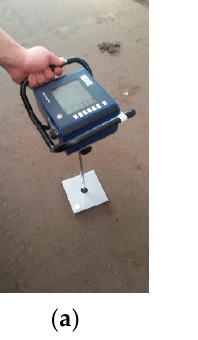
Figure 6. ( a ) Measurement of soil compaction by the electronic penetrometer Penetrologger model 06.15.SA and ( b ) stone placement in prepared soil and measurement of the initial position of the stone using the Bosch PLR 50C laser rangefinder.